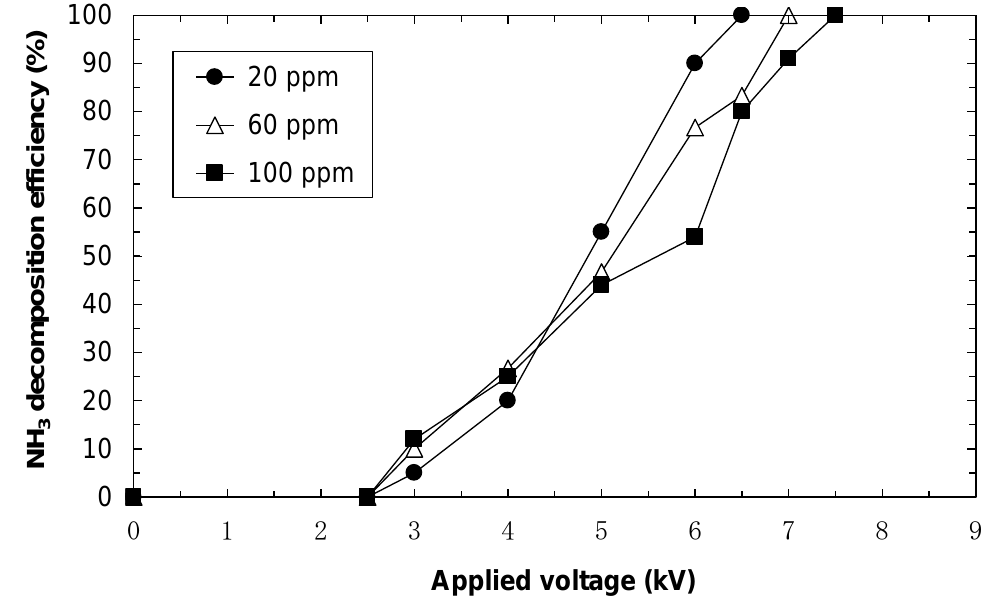
Figure 7. Effect of initial concentration on ammonia decomposition (flow rate = 5.0 L/min, laminated film-electrode plasma